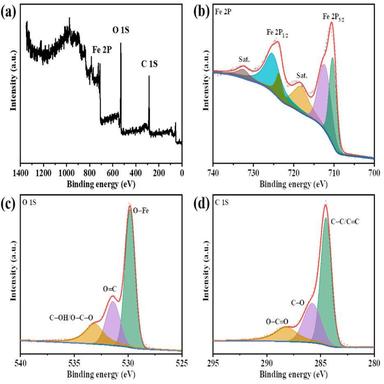
(a) XPS survey spectrum, and (b–d) high-resolution XPS spectra of Fe2p, O1s, and C1s of α-Fe2O3@rGO-10 wt% core@shell nanocubes.